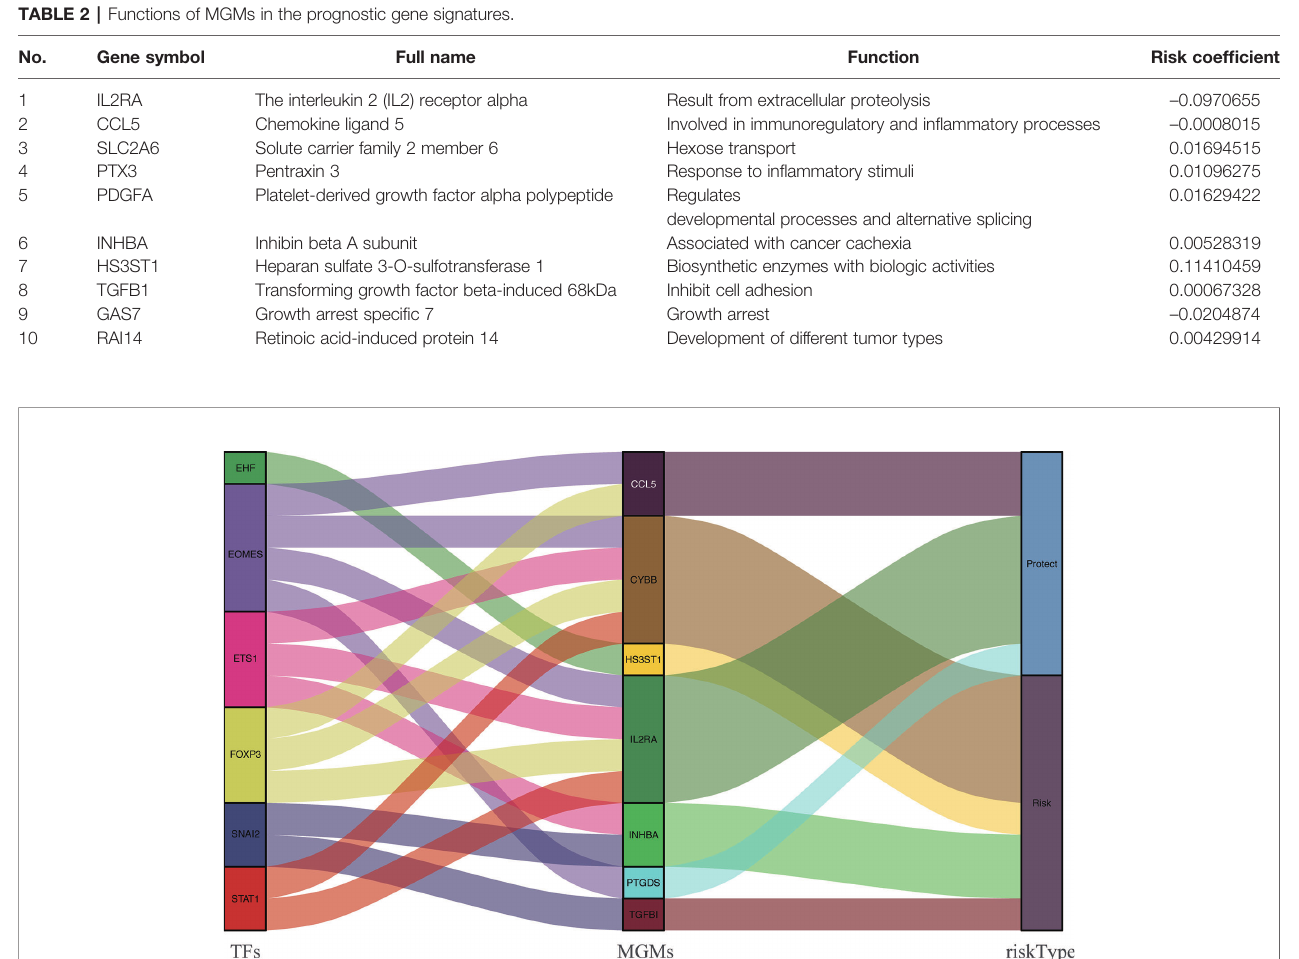
FIGURE 5 | PPI between differentially expressed TFs and the prognostic MGMs with protective or risk type in the Sankey